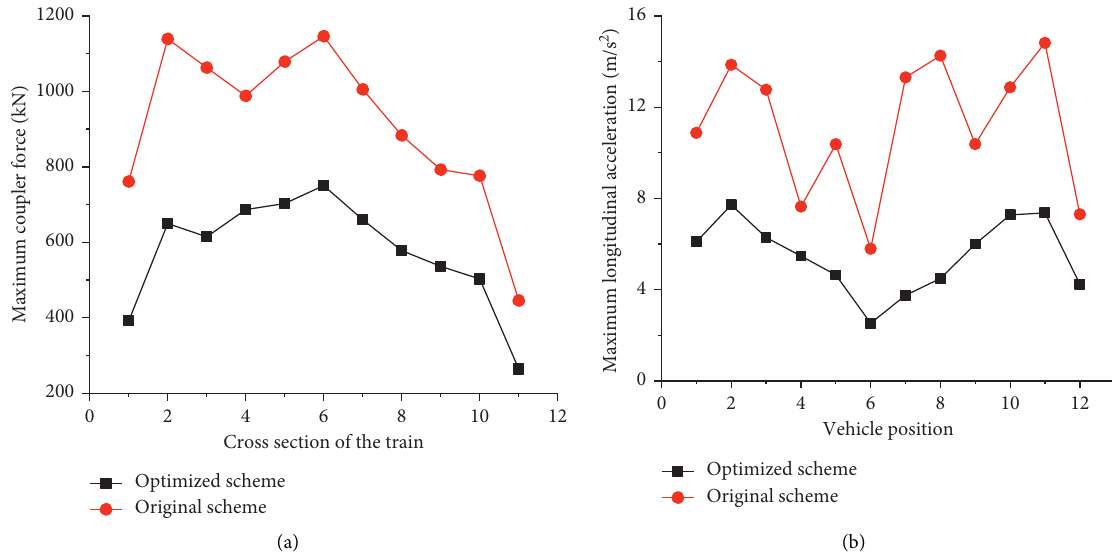
Figure 14: Results comparison of AW0 rescues AW3 before and after optimization. (a) Maximum coupler forces. (b) Maximum lon- gitudinal